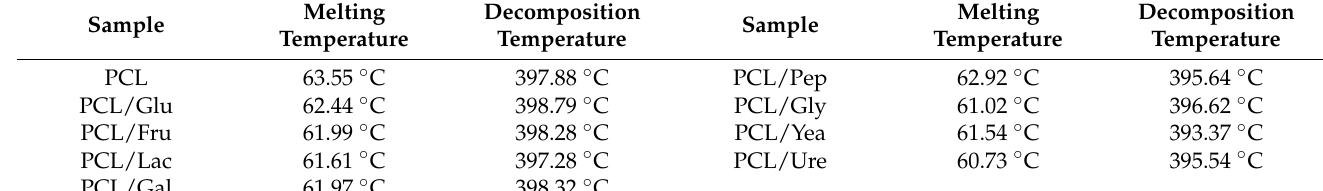
Table 3. Characteristic temperatures of differential scanning calorimetry.